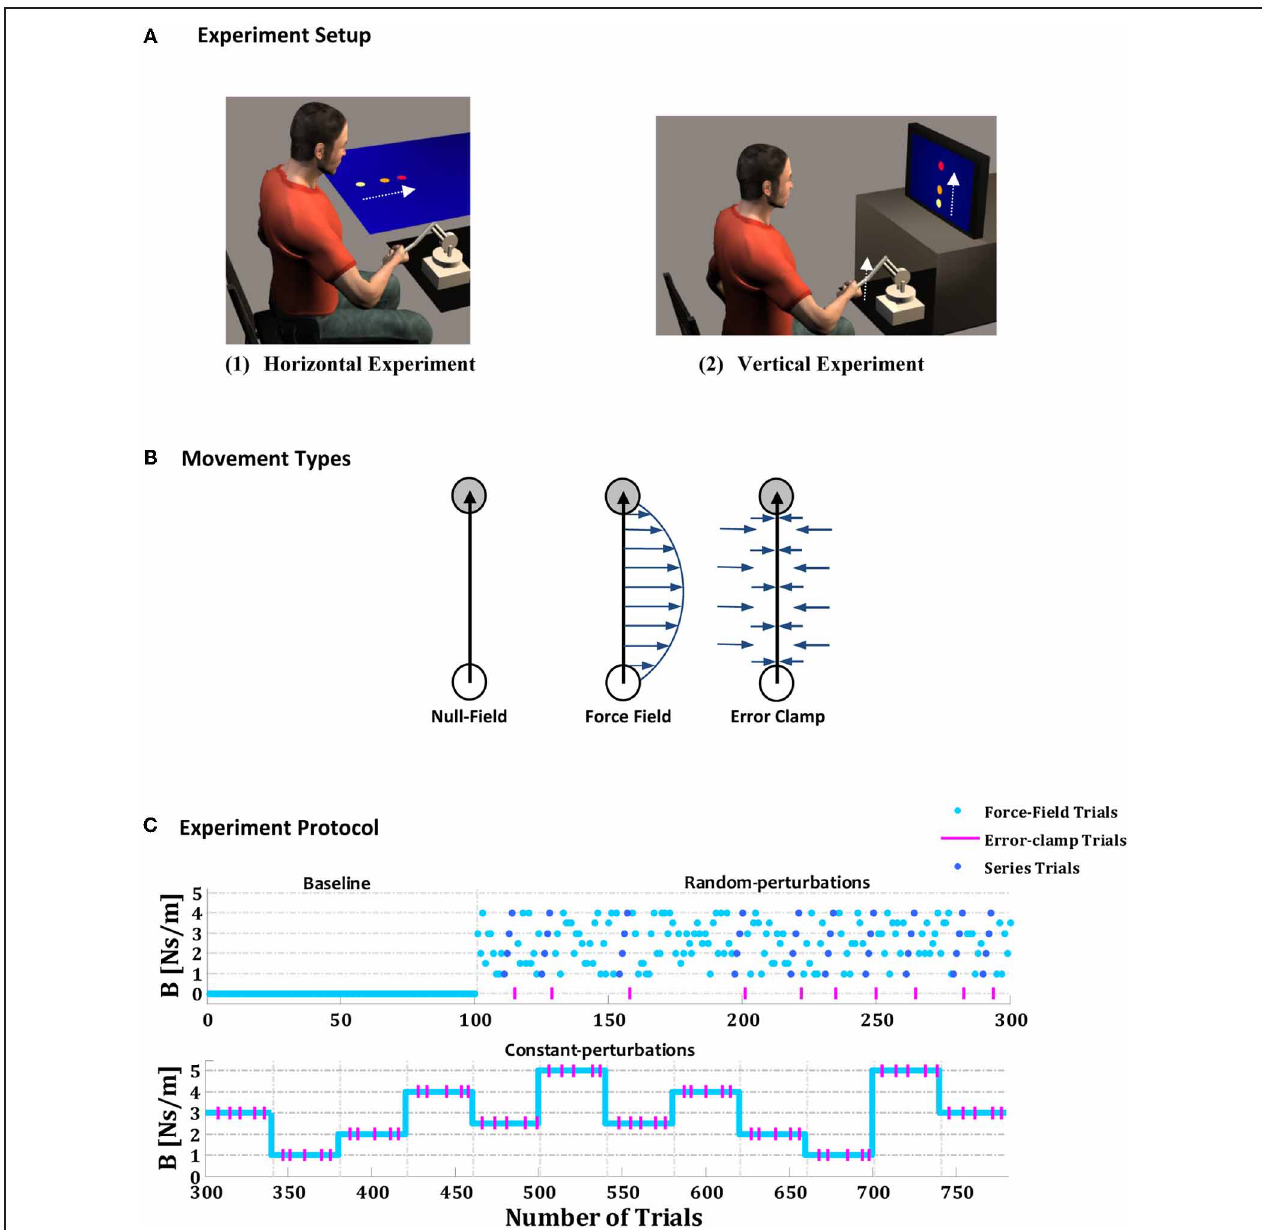
FIGURE 1 | Experimental setup, movement types and experimental protocol. (A) Subjects were instructed to make a point-to-point reaching movement in the horizontal (1) or vertical (2) plane while holding the handle of a two-degrees of freedom robotic manipulandum. (B) Three types of trial were performed: null trials, force-field trials, and error-clamp trials. During the null-field trials, the robot’s motors were turned off, and no force field was applied. During the force-field trials, the robot’s motors were used to produce a viscous force field (arrows) on the subject’s hand proportional in magnitude and perpendicular in direction to the instantaneous the velocity of